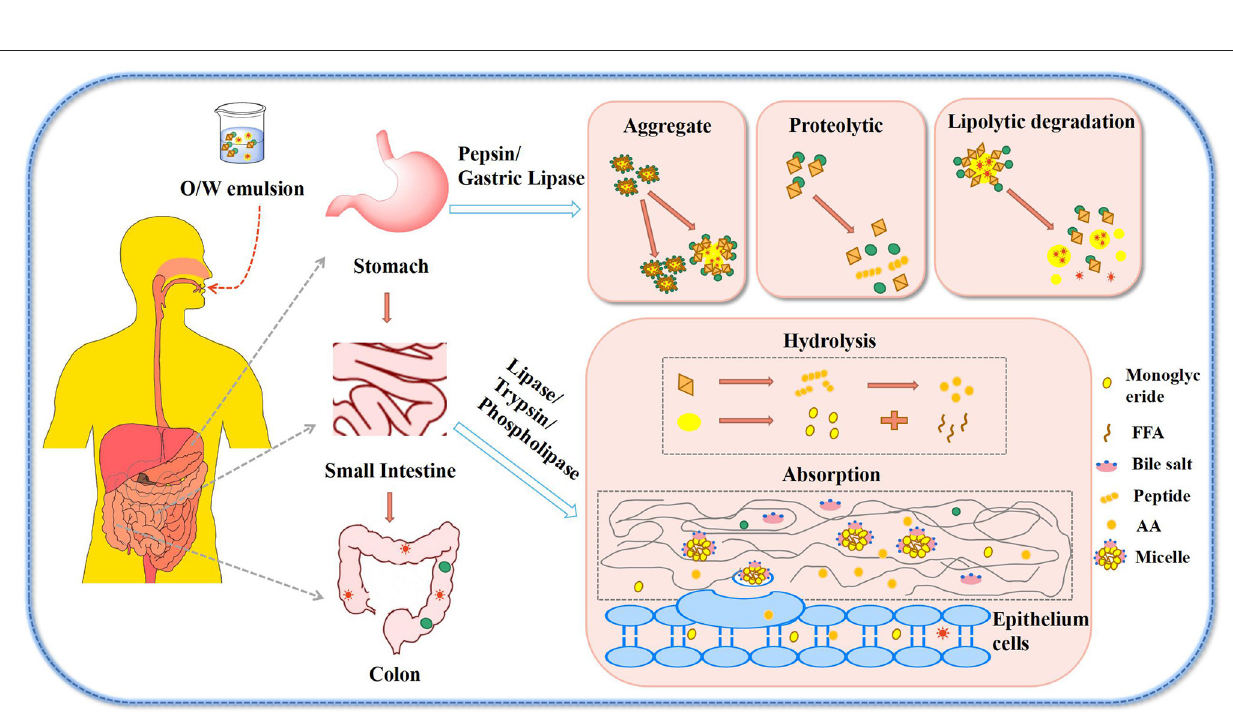
Frontiers in Nutrition |